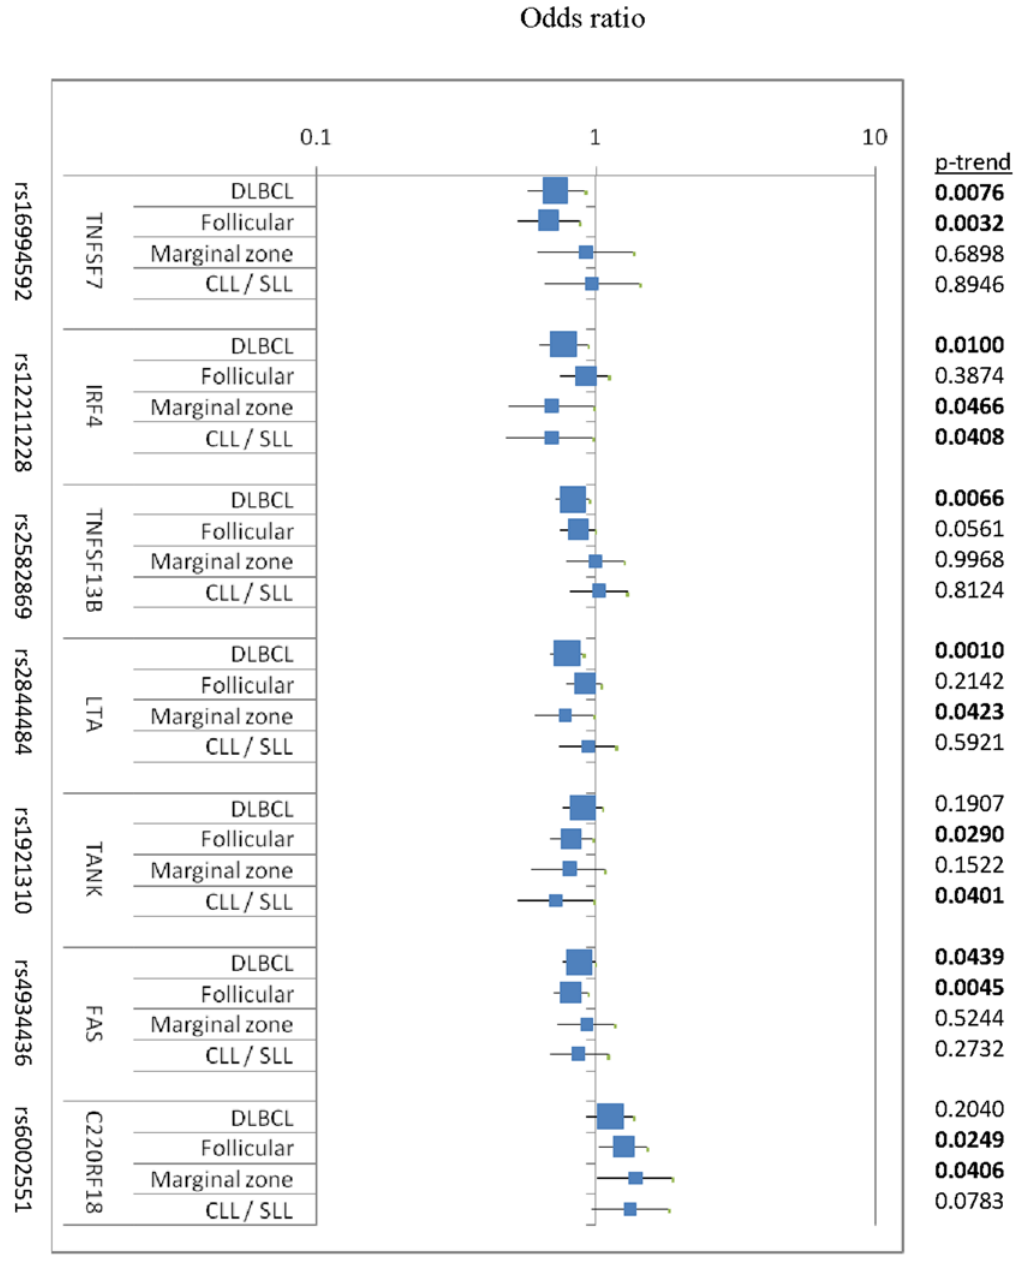
Figure 2. Odds ratios, 95% confidence intervals of additive model for SNPs with p-trends , 0.01 for NHL in pooled analyses; data shown by NHL subtypes DLBCL, follicular, CLL/SLL and marginal zone lymphomas in pooled population (adjusted for age, sex, race, and study site). Data for all SNPs by NHL subtype are shown in Supplemental Materials (Table S6).